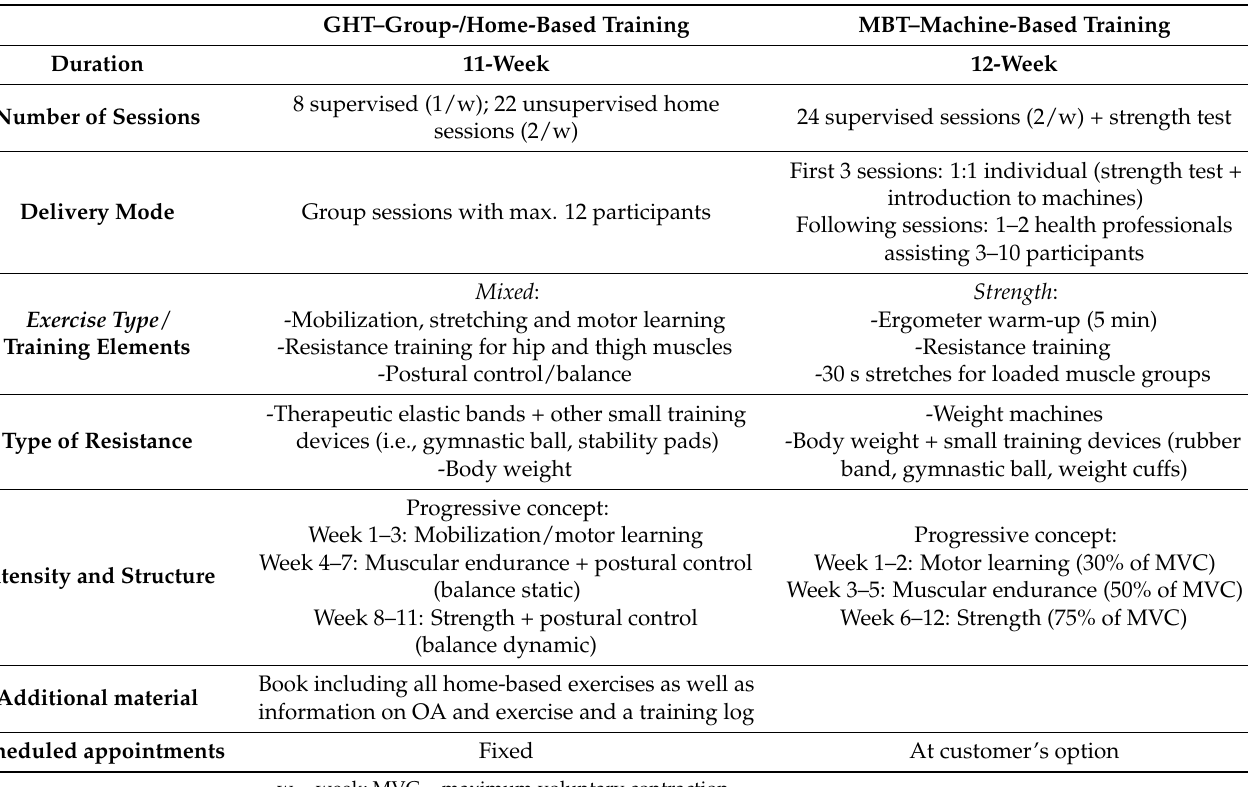
Table 1. Exercise